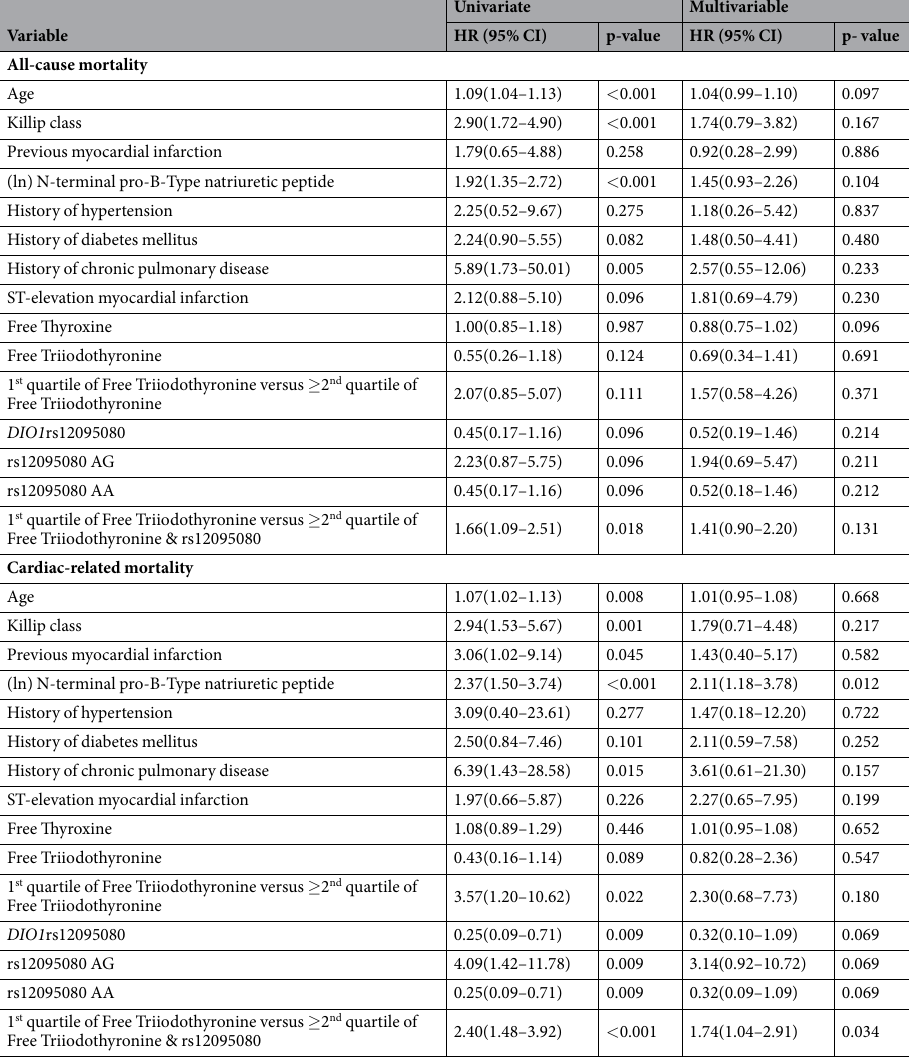
Table 5. Cox regression analysis for factors associated with all-cause and cardiac-related mortality. aMultiple Cox regression analyses adjusted for age, Killip class, previous myocardial infarction, (ln) N-terminal pro-B- Type natriuretic peptide, history of hypertension, history of diabetes mellitus, history of chronic pulmonary disease, ST-elevation myocardial